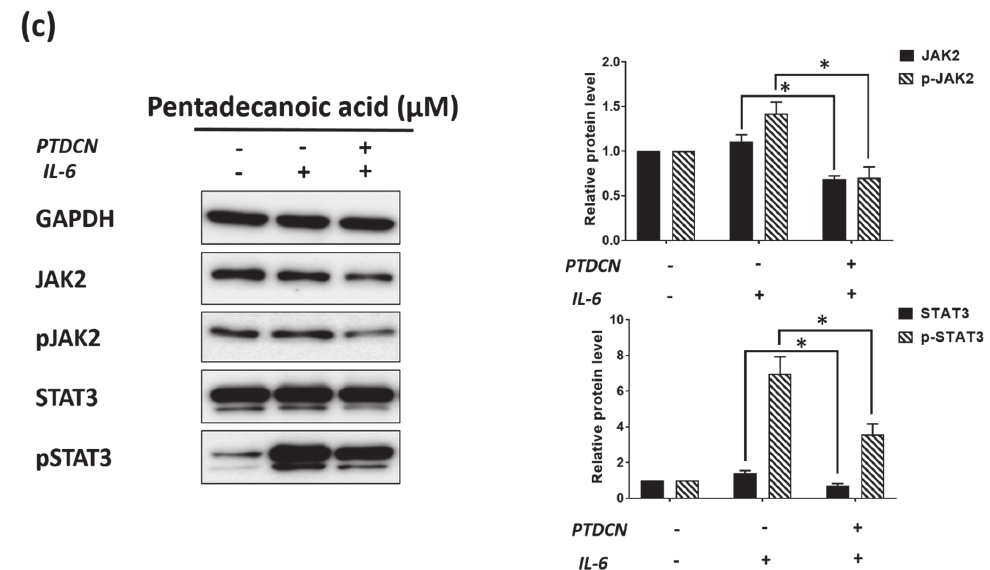
Figure 5. Pentadecanoic acid suppressed JAK2/STAT3 signaling in MCF-7/SC. ( a ) Representative Western blot analysis showing the dose-dependent effects of pentadecanoic acid on the expression of STAT3, pSTAT3, JAK2, and pJAK2 in MCF-7/SC following 48 h of incubation. ( b ) Representative Western blot analysis showing the time-dependent effects of 100 μ M pentadecanoic acid on the expression of STAT3, pSTAT3, JAK2, and pJAK2 in MCF-7/SC. ( c ) Effects of pentadecanoic acid on IL-6-inducible JAK2/STAT3 signaling. MCF-7/SC were pre-treated with 150 μ M pentadecanoic acid for 48 h and stimulated with 20 (cid:569) ng/mL of IL-6 for 15 min. In Figure 5c, PTDCN indicates